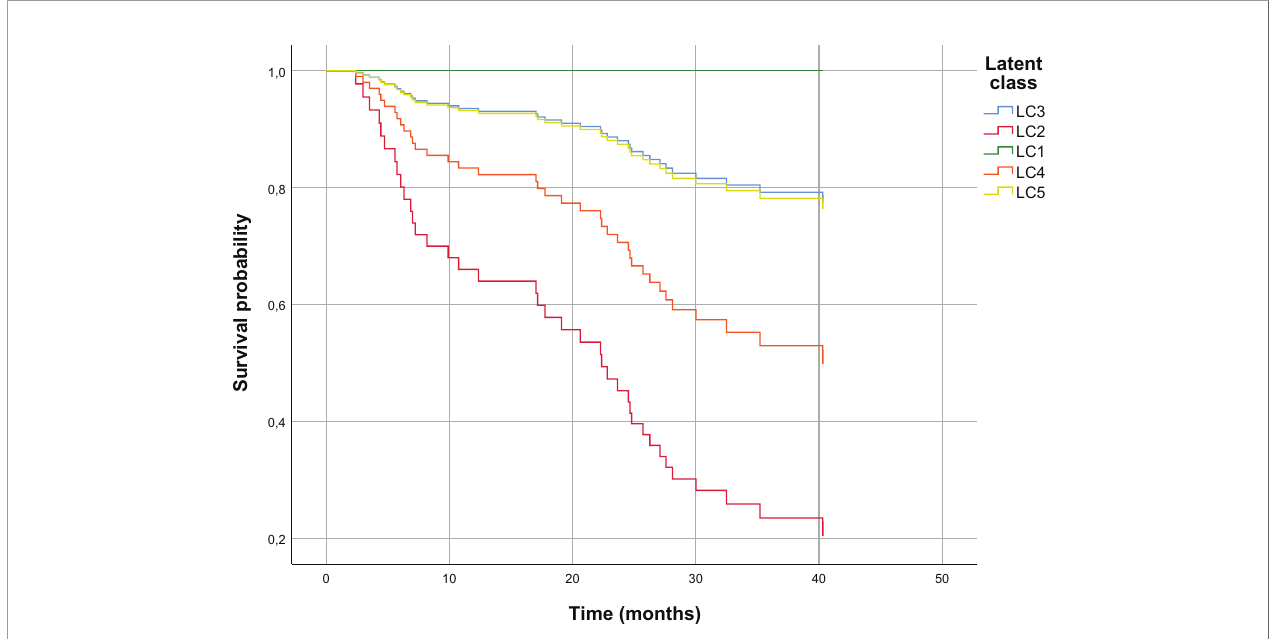
FIGURE 3 | Survival function using Cox proportional hazard regression analysis to predict severe